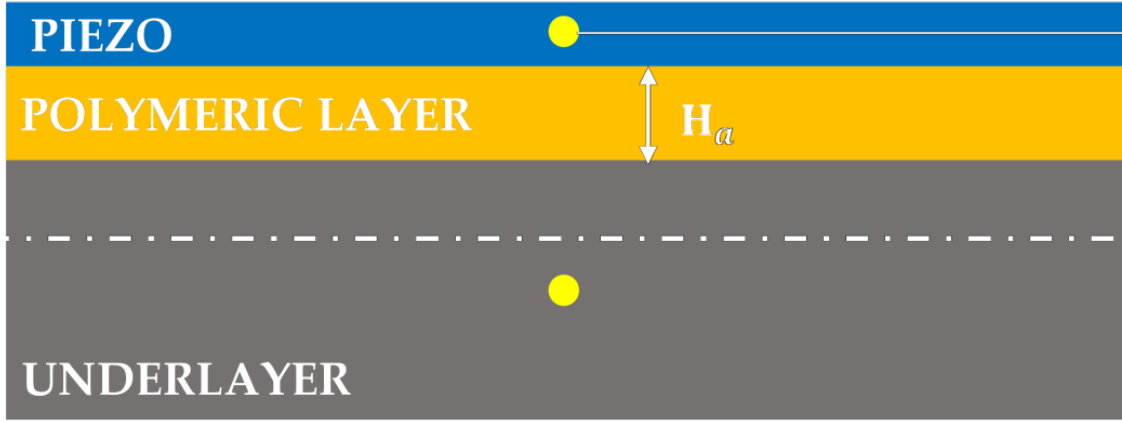
Figure 16. Cross-section of the model with the interposed layer.